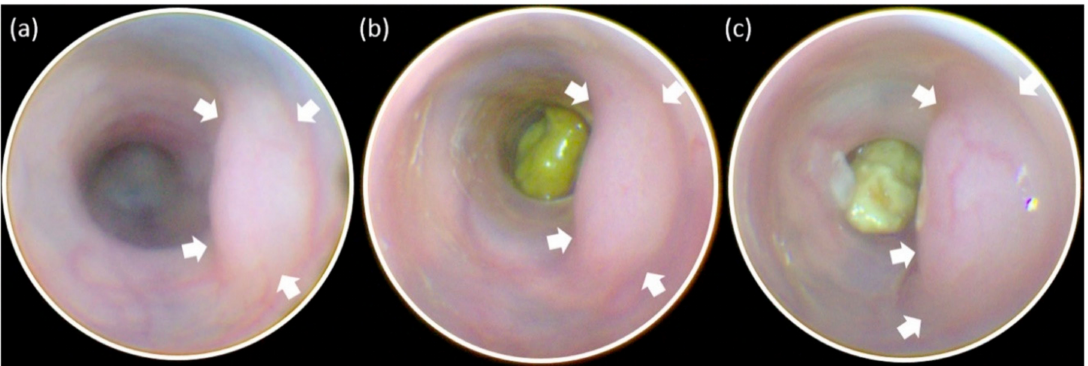
Figure 3. Endoscopic follow-up of orthotopic colon tumor. Tumor growth after ( a ) 20 days, ( b ) 22 days, and ( c ) 27 days from MC38 colon cancer cell implantation. A gradually increased tumor volume (white arrows) is shown with serial endoscopic